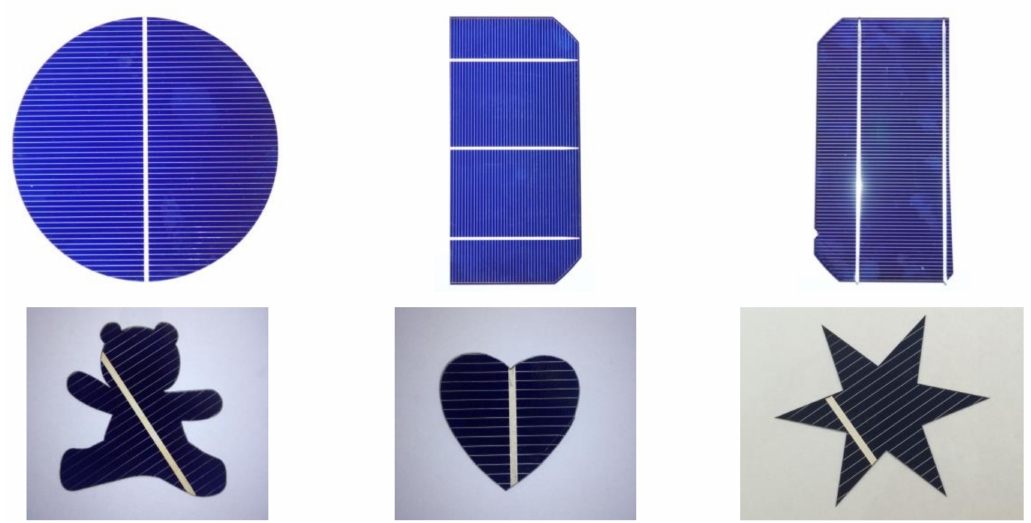
Figure 3. Shapes of monocrystalline silicon cells that have been cut with the laser technology.